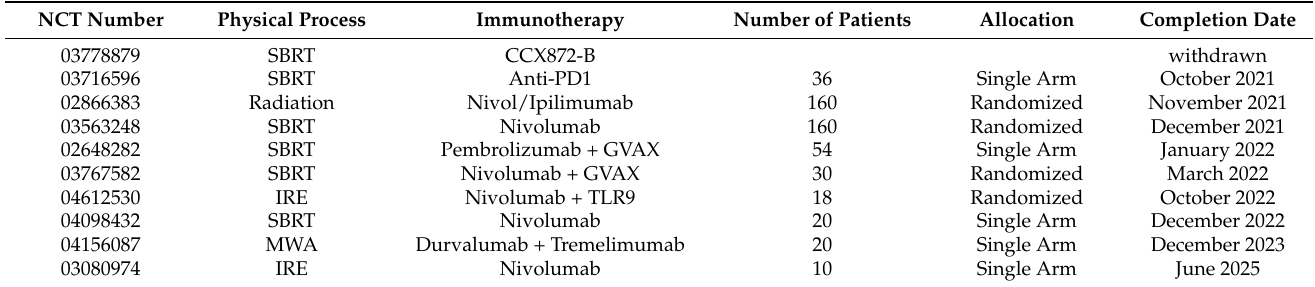
Table 3. Ongoing trials involving combined treatment strategies for advanced PDAC (stage